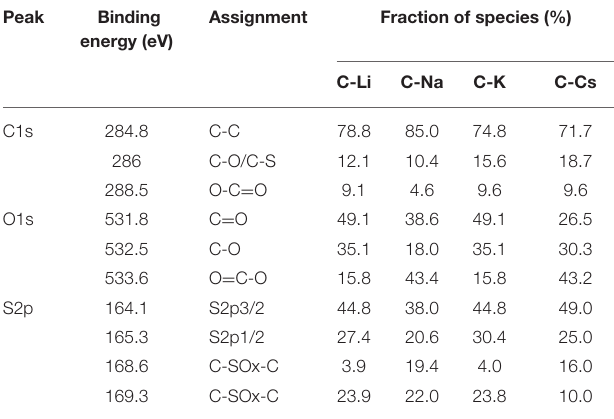
TABLE 2 | Peak assignment of C1s, O1s, and S2p for the prepared